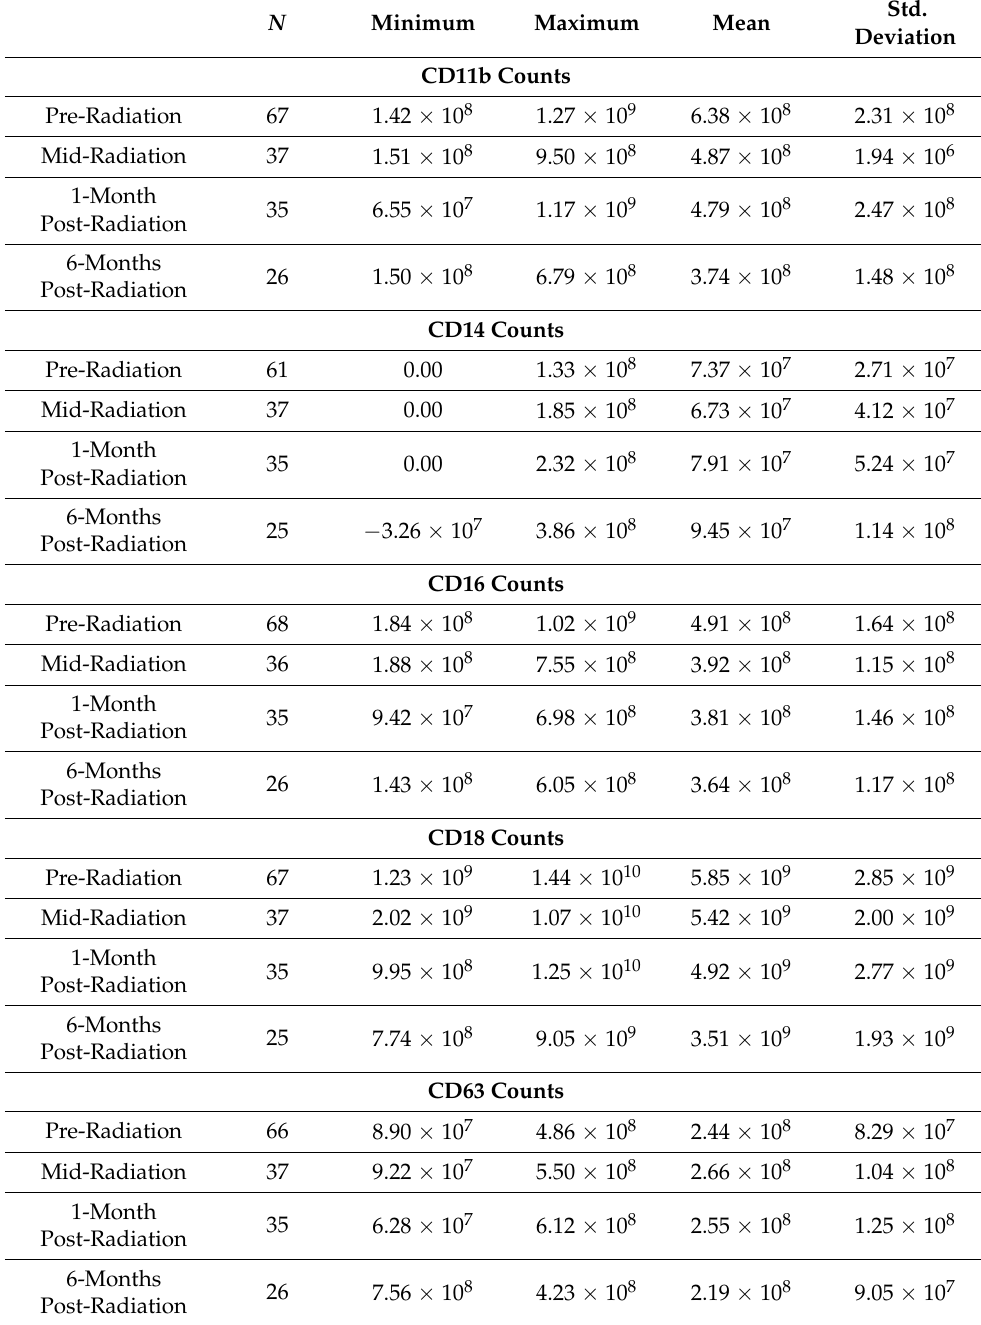
Table A5. oPMN marker counts and descriptive